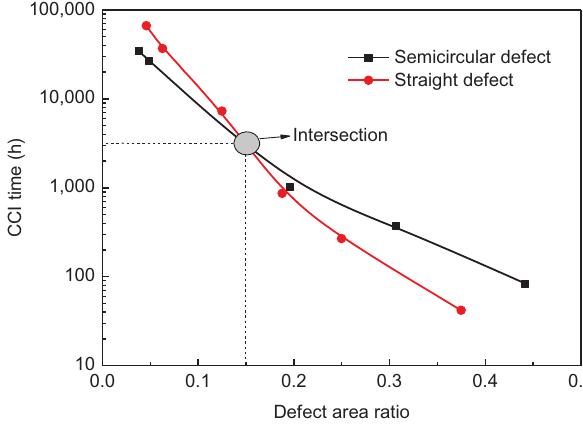
Figure 14: The axial stress variation with time of center point for semicircular (a) and straight (b) defects. Figure 15: The variation of CCI time with defect area